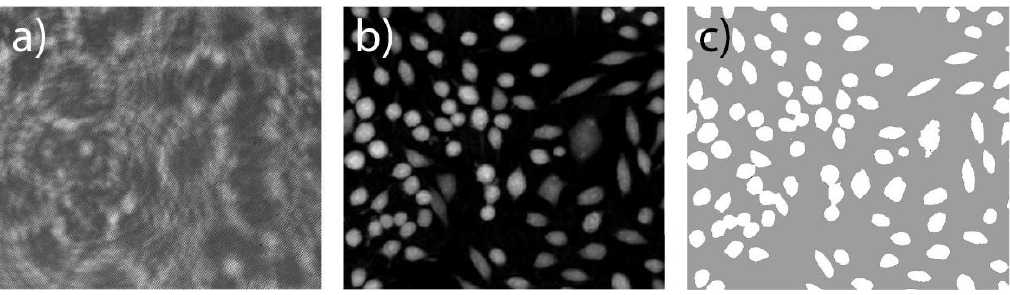
Figure 1. Example of QPI image: ( a ) Interference pattern from digital holography (DH) recording showing cells in transmission mode as seen by the sensor. An interference pattern between object and reference wave has been disturbed by the refraction of cells in the object light path; ( b ) Reconstructed phase image using a Fresnel approximation, numeric refocusing, and unwrapping. Image intensity is proportional to optical path length through the cells; ( c ) Reconstructed phase image with segmented cell areas. Cell regions (white) have been separated from background (grey) using a simple thresholding. Scale: 200 × 175 µm 2 , human prostate DU145 cells in a T25 flask.